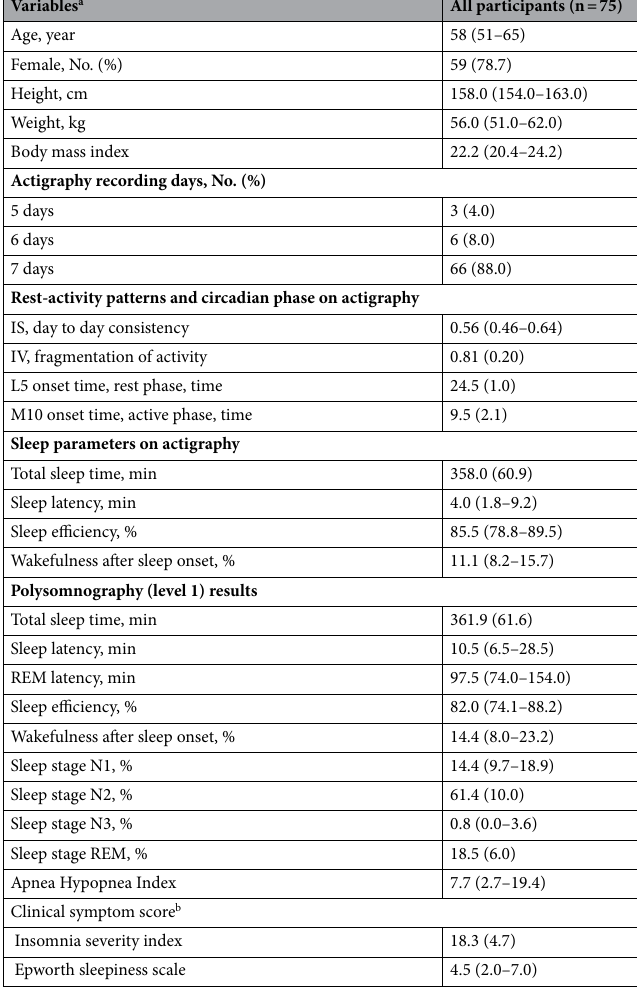
error], Group 1: 20.8 [1.3] vs Group 2: 17.7 [0.6]; P = 0.04). No significant between-group differences were noted in other PSG parameters or Epworth Sleepiness Scale (ESS) scores.